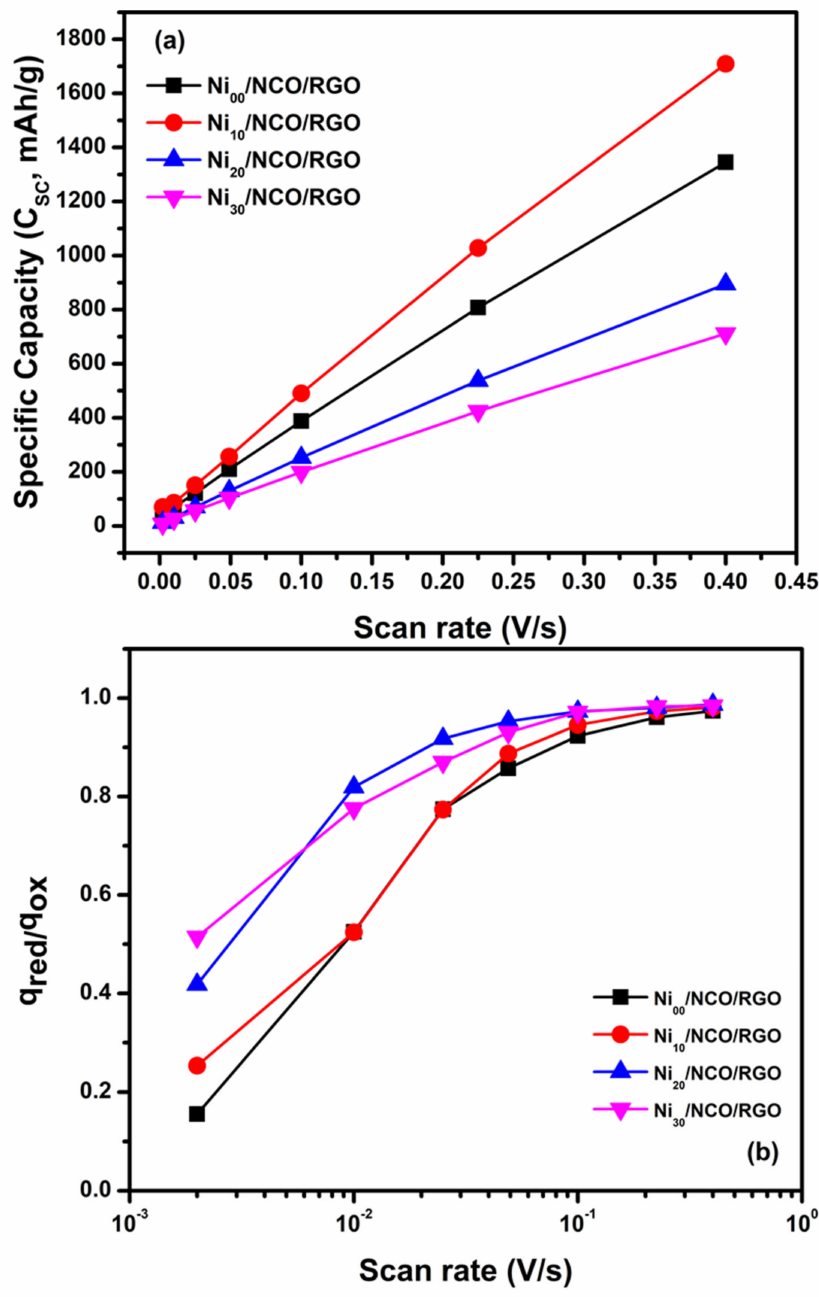
Figure 7. ( a ) Specific capacity and ( b ) coulombic efficiency q red /q ox for various Ni/NCO/RGO electrodes at various scan